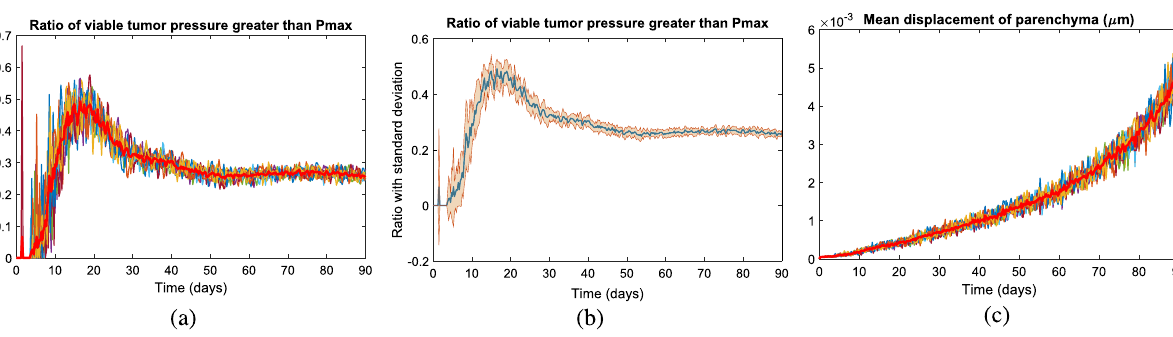
Figure 6. Pressure distribution of viable tumor cells and the displacement distribution of parenchyma at t = 90 days, where r E = 0.05 (1/min), r P = 0.0005 (1/min) and d max = 0.75 µ m .